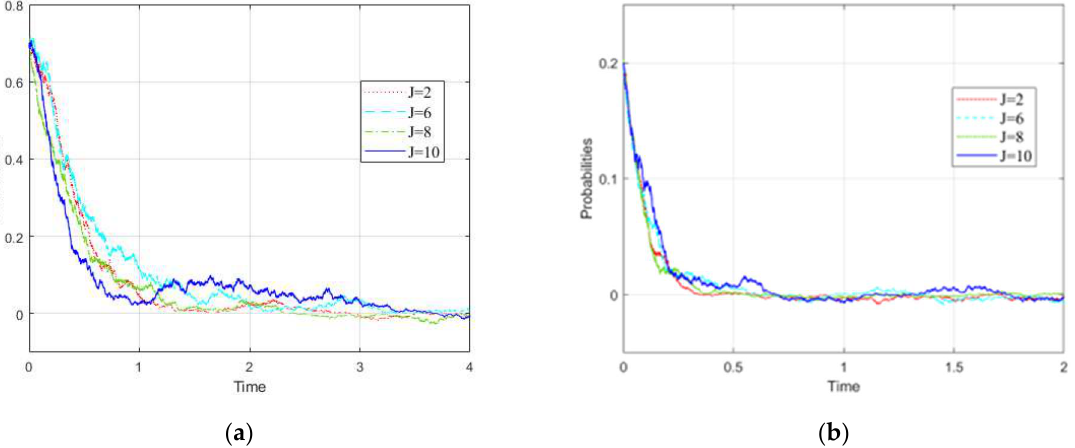
Figure 6. Influence rule of J change on Branch Government 1: ( a ) influence rule of J change on Branch Government 1 when x (0) = 0.7, y (0) = 0.7, z (0) = 0.7, and ( b ) influence rule of J change on Branch Government 1 when x (0) = 0.2, y (0) = 0.2, z (0) = 0.2.